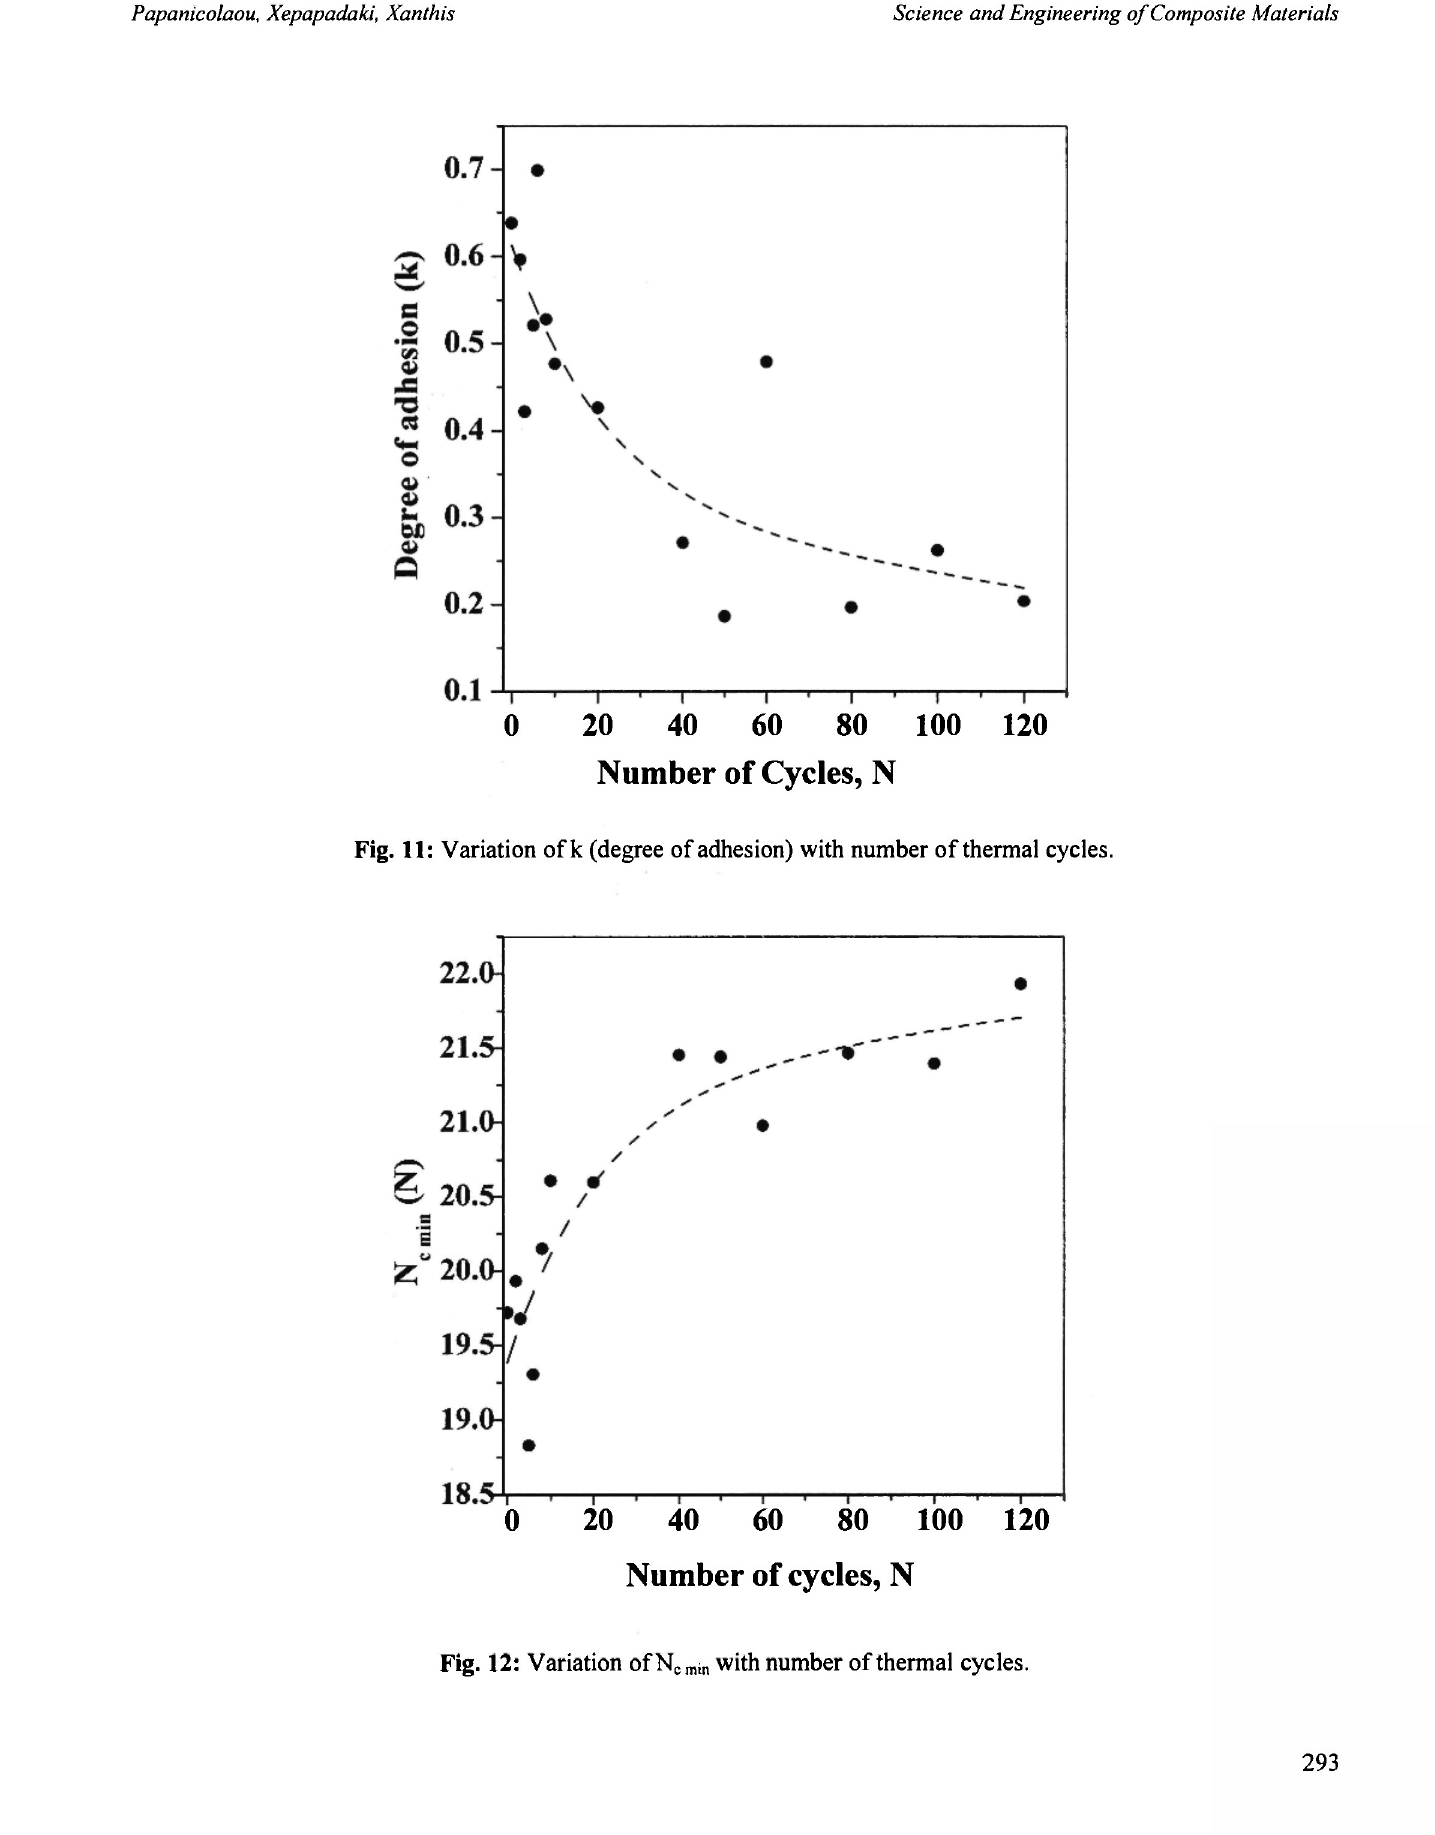
Fig. 11: Variation of k (degree of adhesion) with number of thermal cycles.